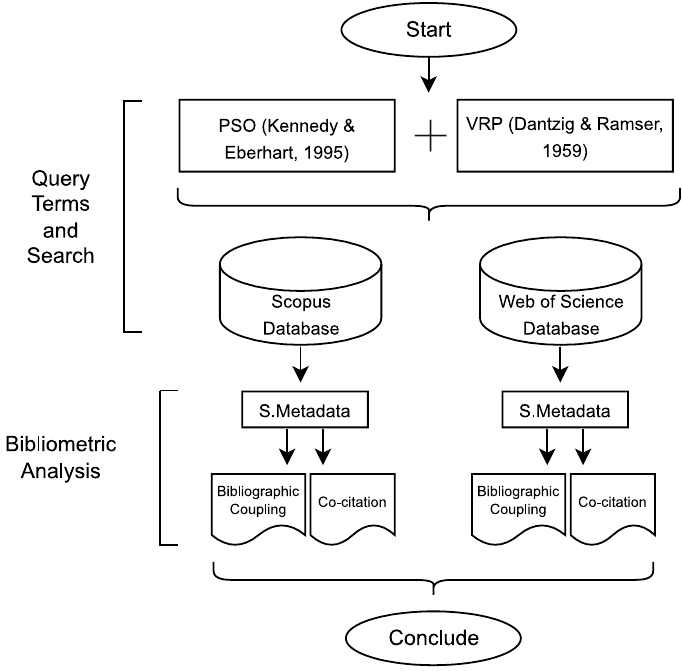
Figure 2. PSO + VRP bibliometric study methodology chart [3,15].